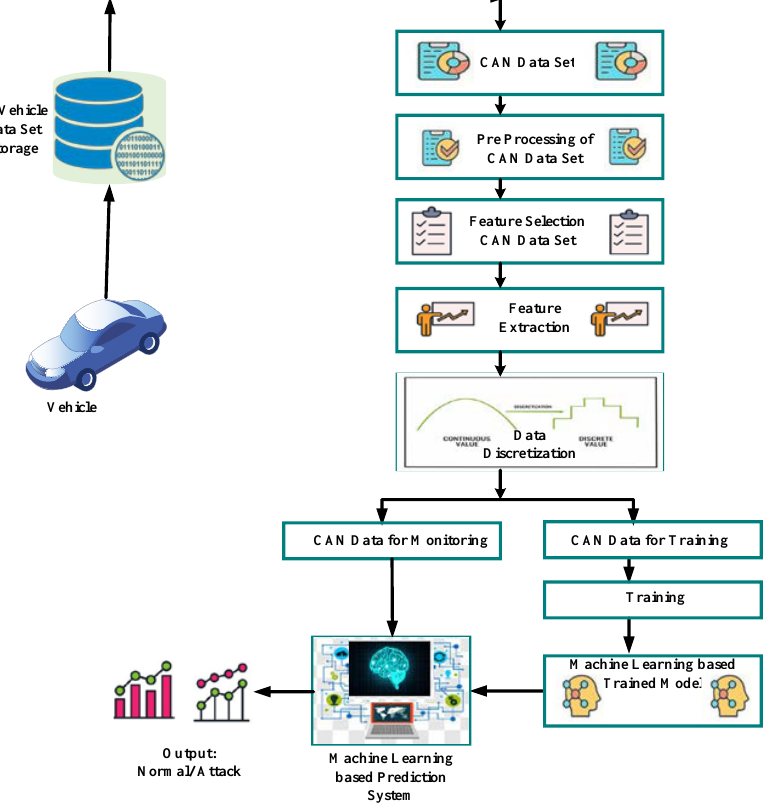
Figure 10. General Flow Diagram reflecting series of steps for intrusion detection using machine learning model.